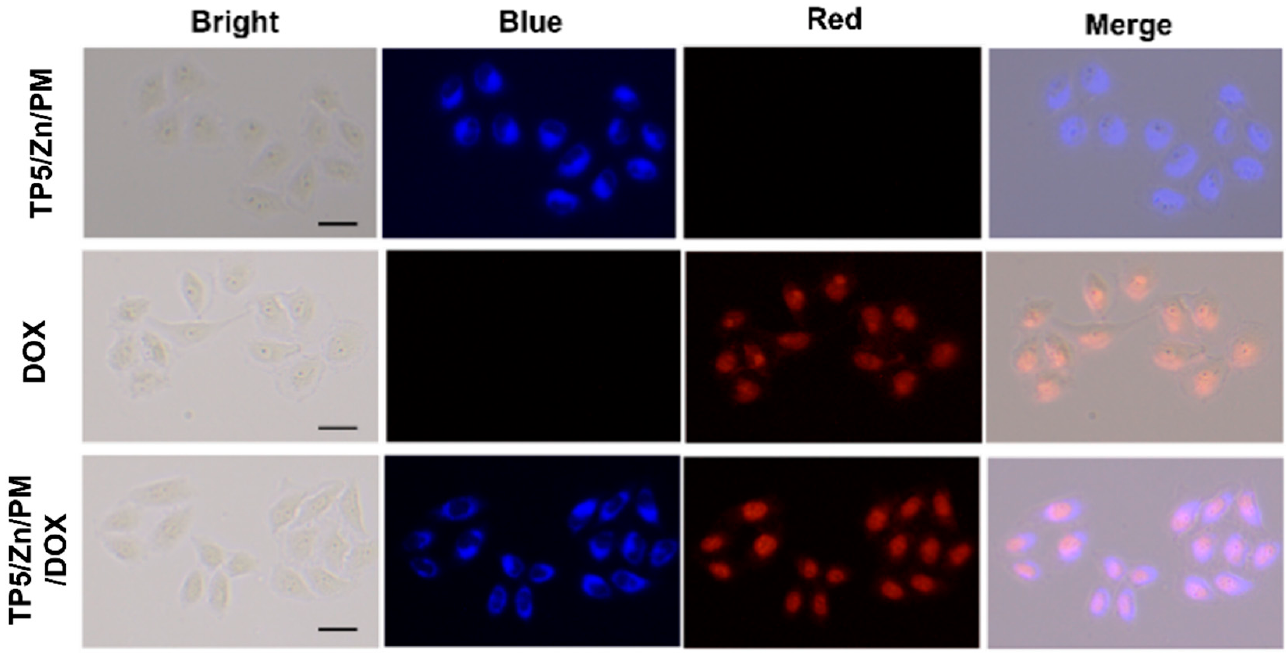
Figure 4. Fluorescent images of HeLa cells treated with TP5/Zn/PM , Dox and TP5/Zn/PM/ Dox for 4 h, respectively.